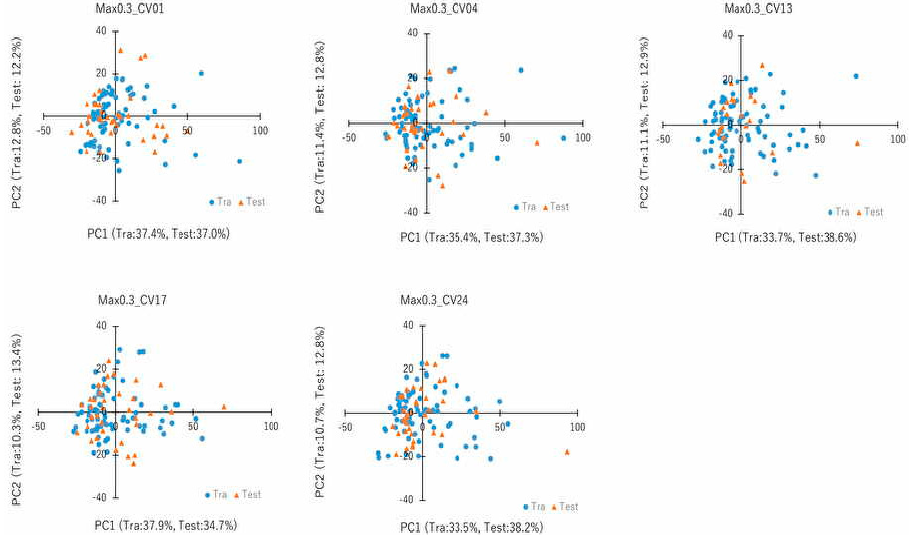
Figure 3. PCA of molecular descriptors. PC1 and PC2 indicate principal components 1 and 2, respectively. Tra and Test datasets are shown by blue dots and orange triangles, respectively. Five datasets with the threshold of top ≥ 30% are denoted as MAX0.3_CV01, MAX0.3_CV04, MAX0.3_CV13, MAX0.3_C17, and MAX0.3_CV24.